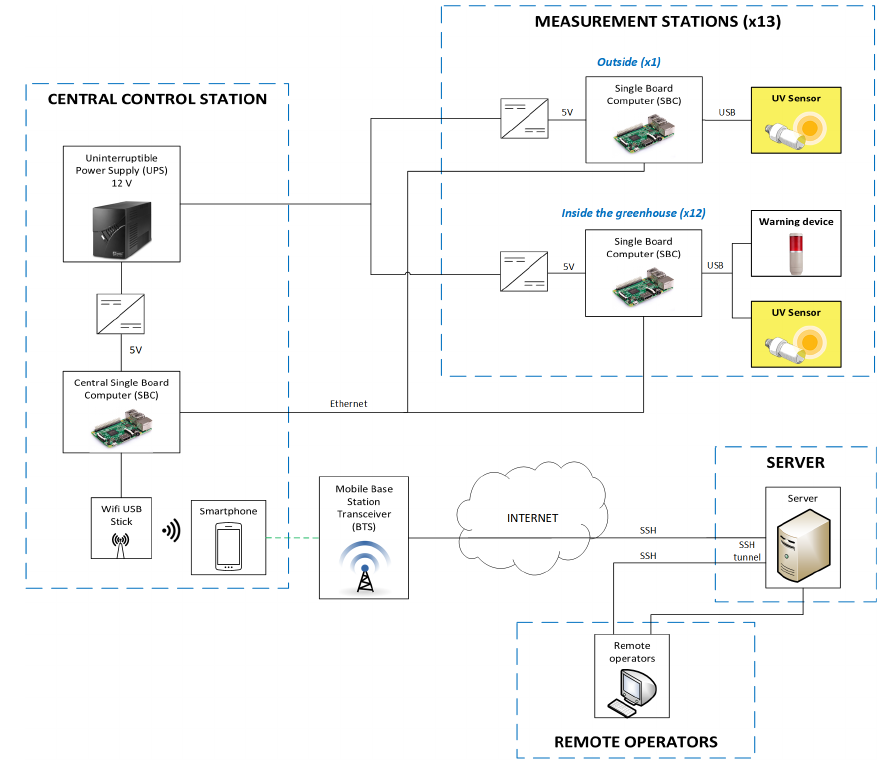
Figure 4. Diagram of the designed data network